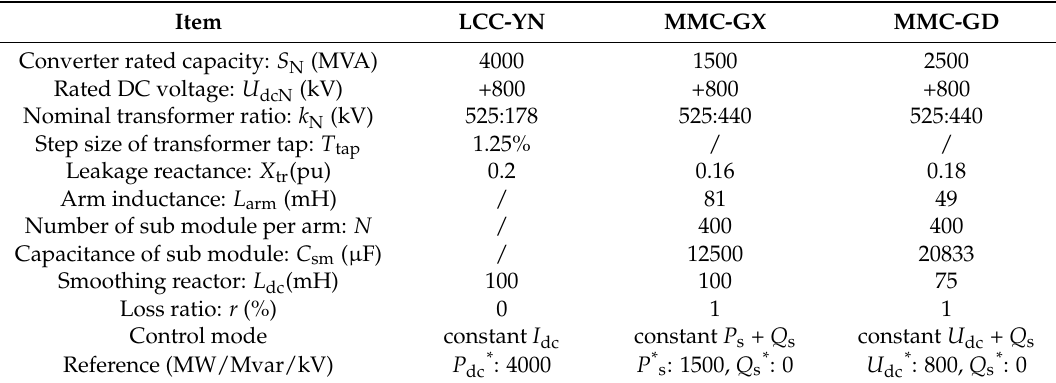
Table A2. Monopole System Parameters of Case 1.